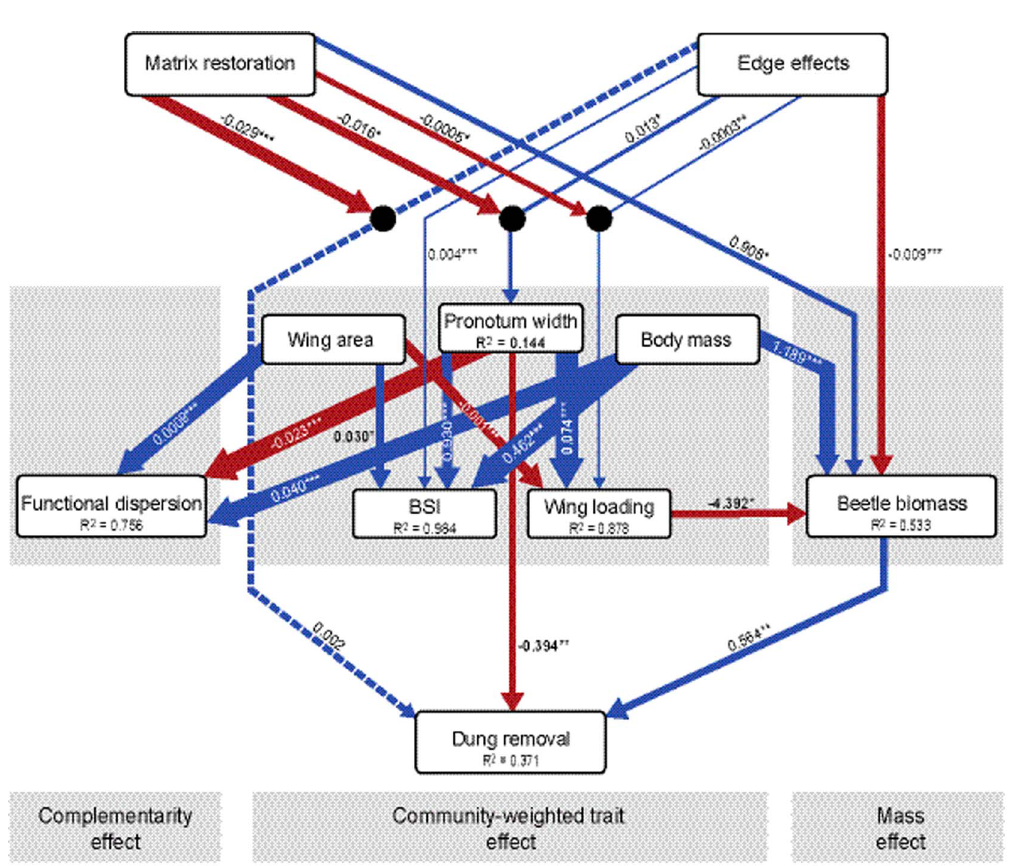
Fig. 3. Causal pathways of functional responses to edge effects and matrix restoration. Best-fit generalized multilevel path model structure ( x 2 5 44.964, df 5 54, P 5 0.805) as determined by the B U set of independence claims (Table S4). Boxes depict predictor and response variables and arrows indicate significant positive (blue) and negative (red) effects, with non-significant effects indicated by a dashed arrow. Circular nodes with arrows leading to them represent interaction terms. R 2 values in the endogenous variables indicate the strength of fit for individual models. Values within and adjacent to arrows are the unstandardized path coefficients with level of significance (* p , 0.05, ** p , 0.01, *** p , 0.001). Line weightings indicate the relative strength of effects as derived from the standardized path coefficients.